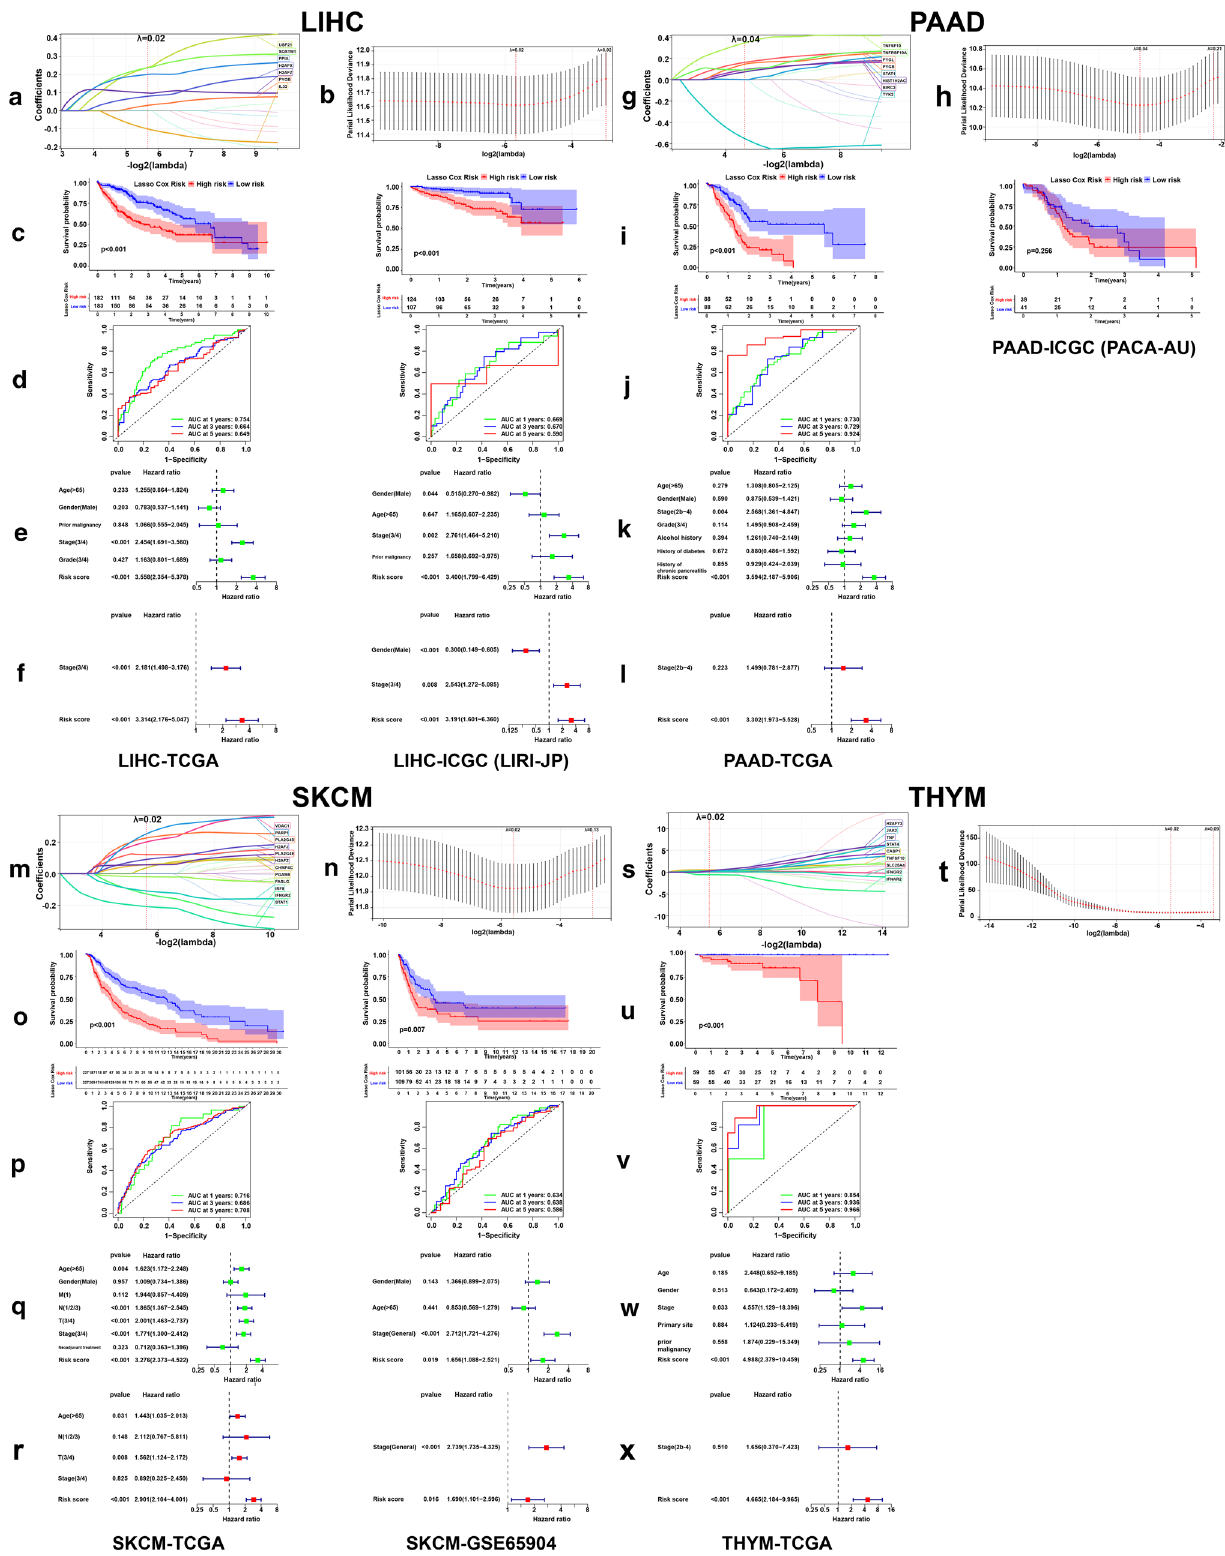
Fig. 5 Risk model construction and validation based on prognostic DENGs in LIHC, PAAD, SKCM and THYM. LASSO coefficient spectrum of the selected genes ( a , g , m , s ) and the fivefold cross-validation ( b , h , n , t ) for variable selection were shown. Kaplan–Meier plots ( c , i , o , u ), time-dependent ROC curves of 1, 3, 5-years ( d , j , p , v ) and forest plots ( e , f , k , l , q , r , w , x ) showed the prognostic effectiveness of the risk